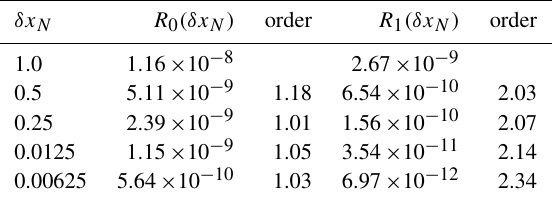
Table 1. Taylor remainders R 0 = | b J(x N ( 0 ) + δx N ) | and R 1 =